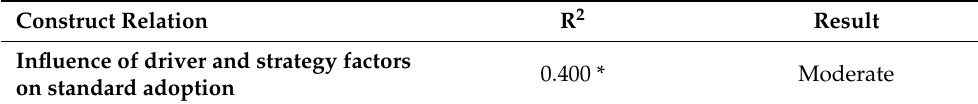
Table 8. R-square of the endogenous latent